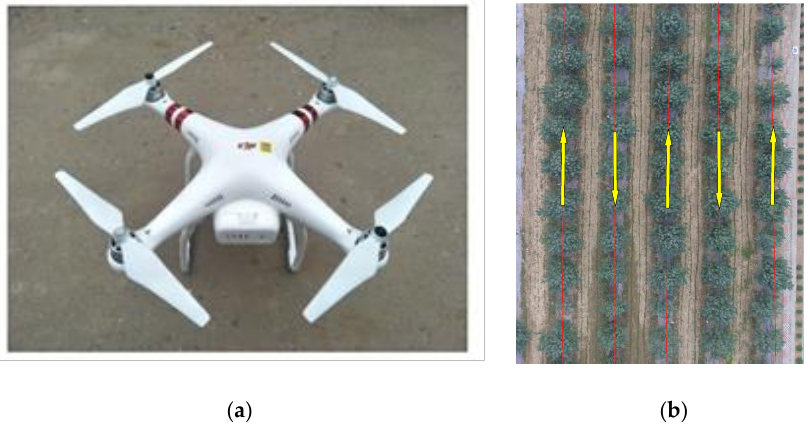
Figure 2. Image acquisition: ( a ) the image acquisition platform (DJI Phantom 3 four-axis aerial photography aircraft); ( b ) the unmanned aerial vehicle (UAV) flight route.